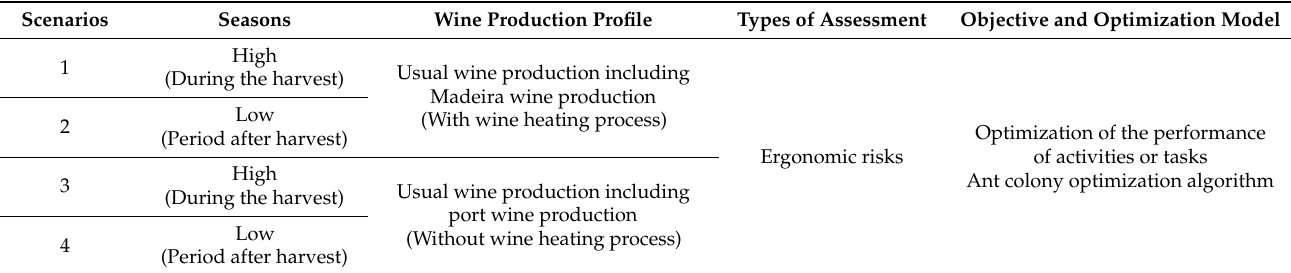
Table 2. Considered scenarios for model